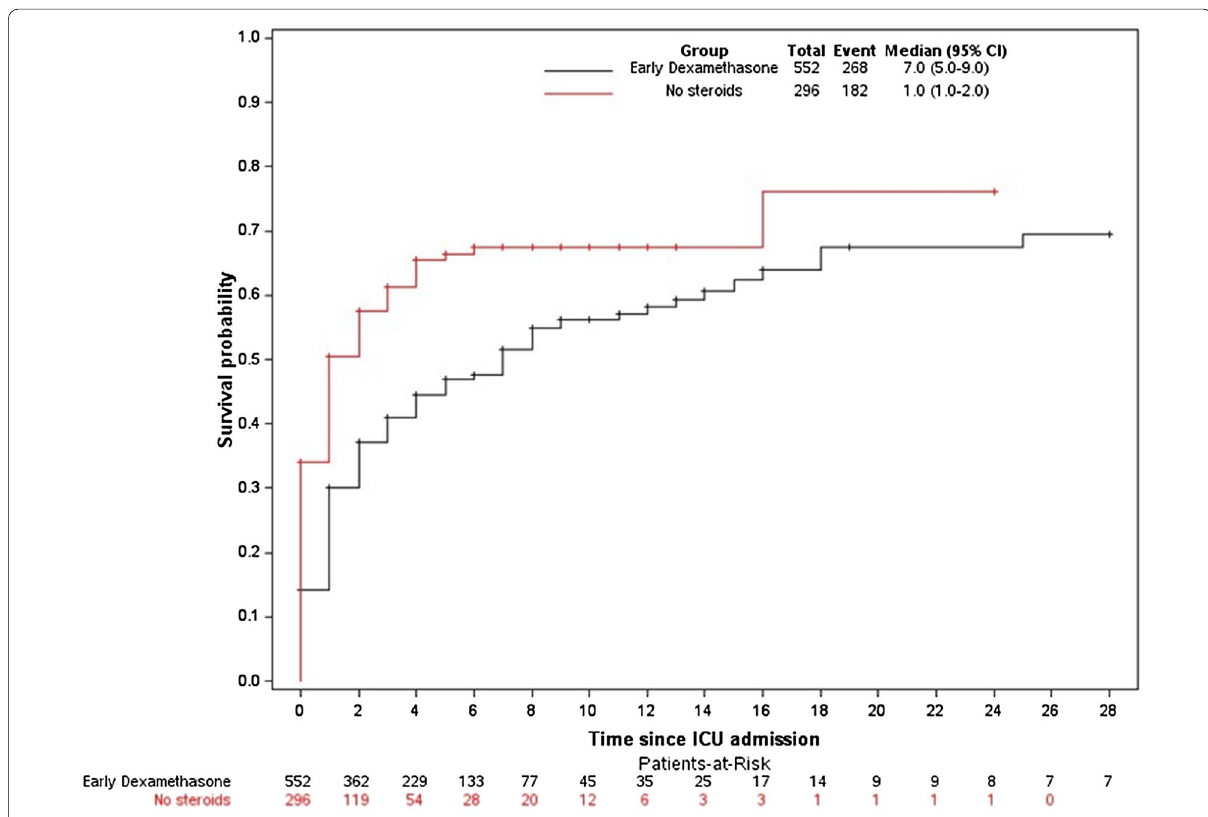
Fig. 4 Probability of intubation during the ICU stay according to treatment